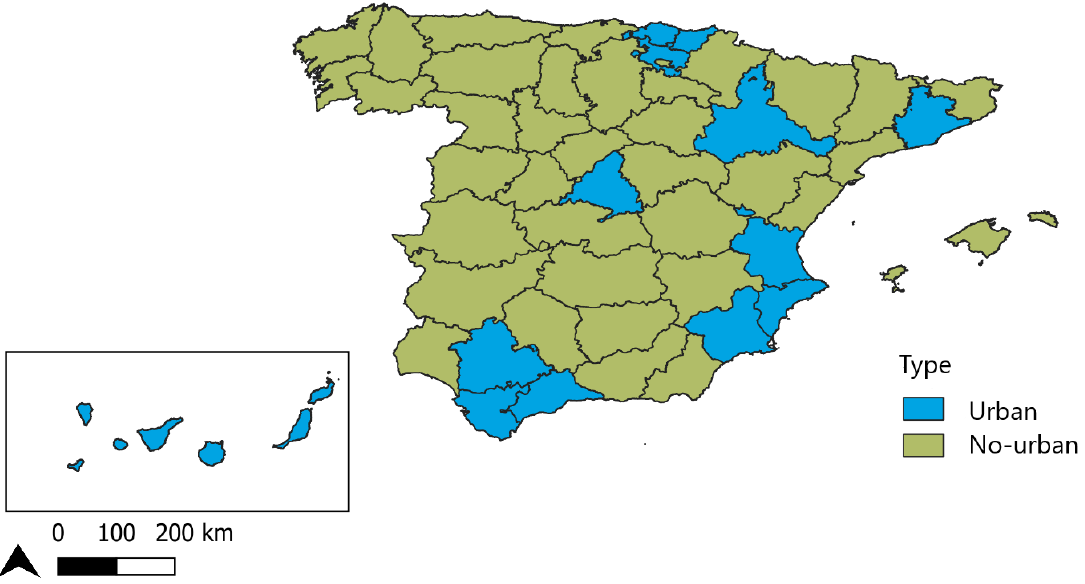
Figure 1. Map of urban and nonurban (intermediate and rural) provinces in Spain, 2015.